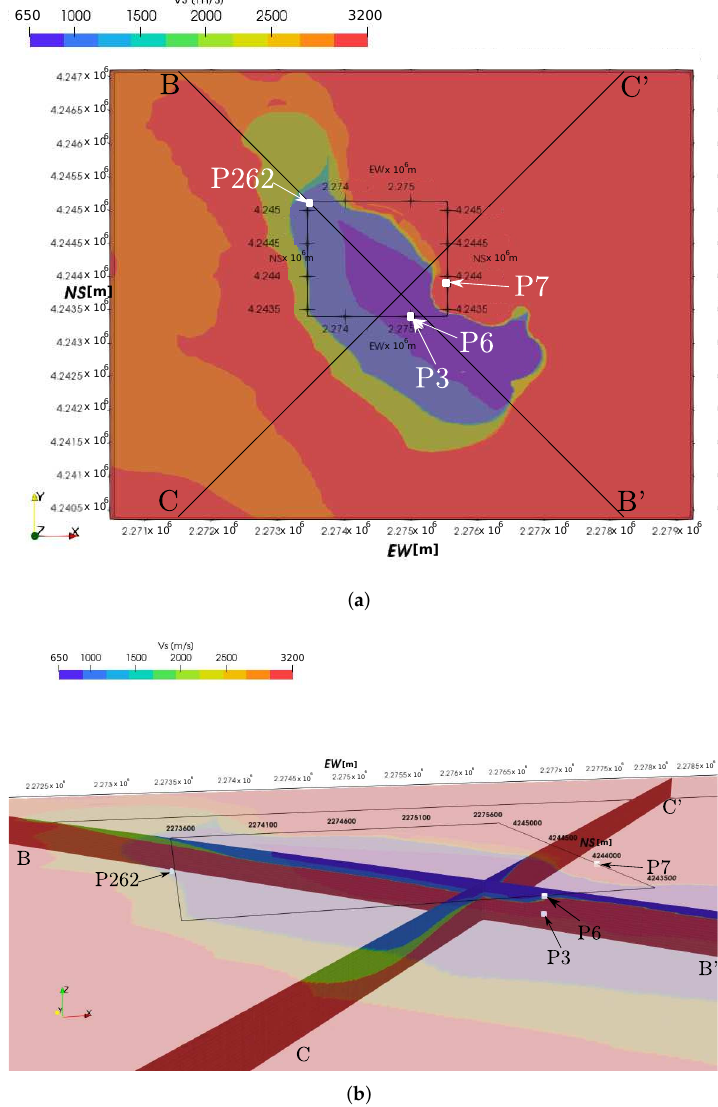
Figure 9. V S structure of the numerical model of the Argostoli basin. Clips B-B’ and C-C’ show the location of the principal monitoring points considered (P3, P6, P7, and